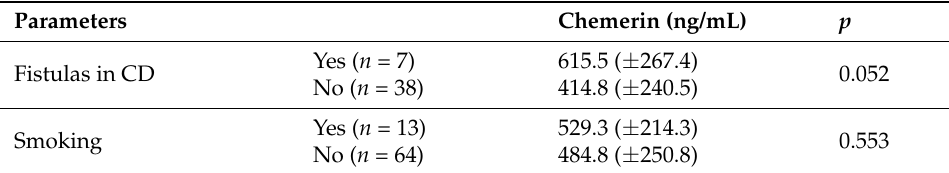
Table 2. Cont . Parameters Chemerin (ng/mL) p Fistulas in CD